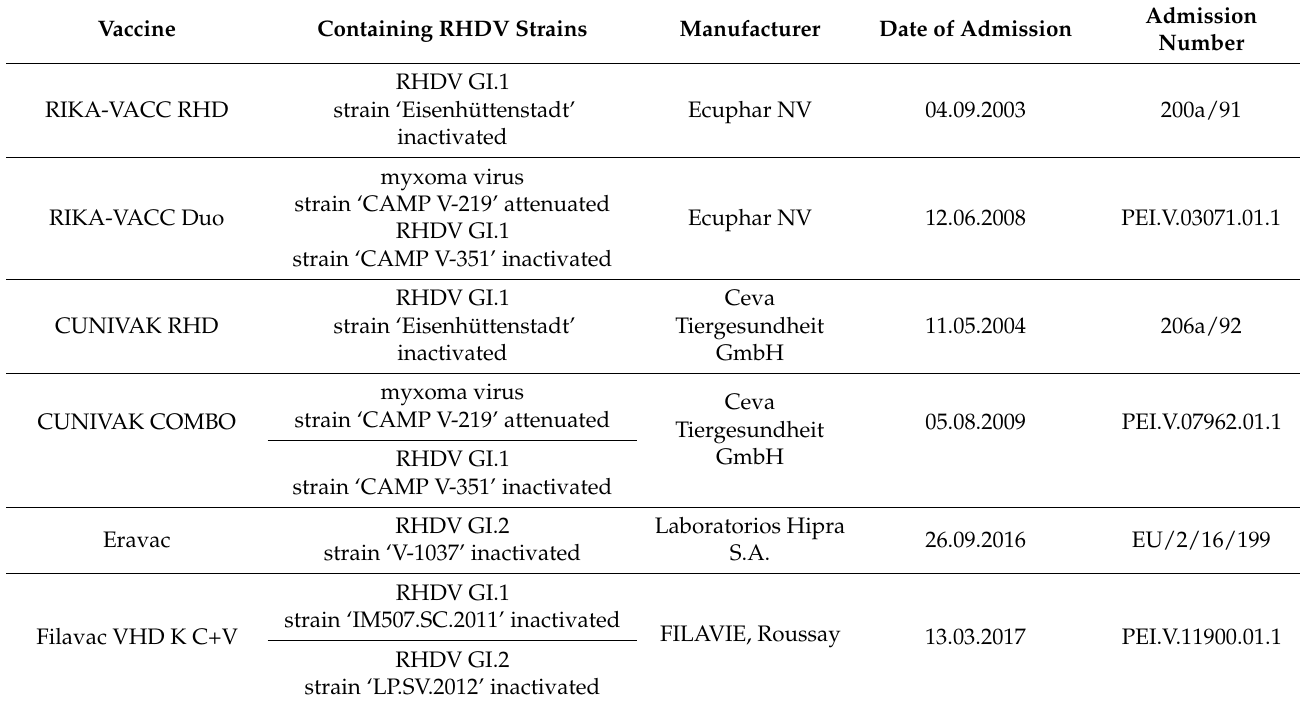
Table 1. Overview of liver-derived vaccines against RHDV, licensed in Germany (PEI, state 11.01.2021). Vaccine Containing RHDV Strains Manufacturer Date of Admission